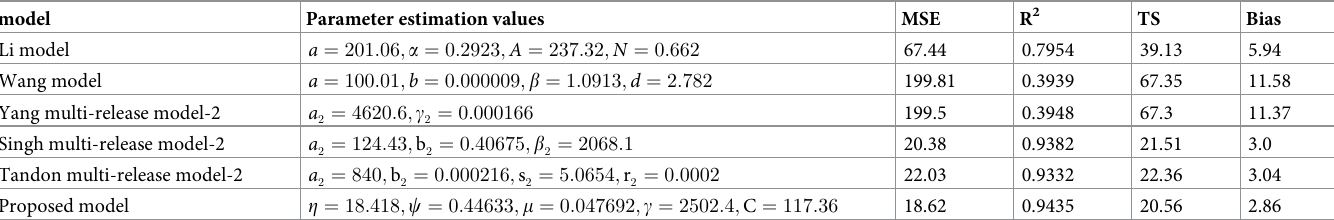
Table 3. Comparison of the fitting performance of models using 100% of fault data (DS1-2).